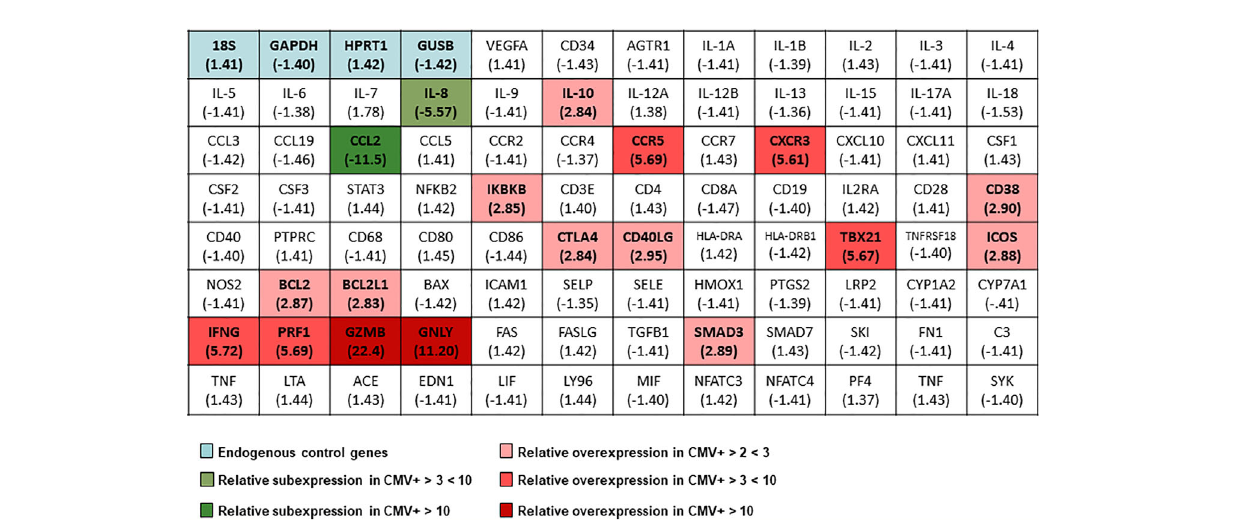
FIGURE 6 | Changes in the gene expression pro fi le in CHF patients divided according to their seropositivity to CMV measured by TaqMan ™ Array Human Immune Response. Heat map showing differential expression in patients with CHF CMV+ compared to CMV- patients. Green colors indicate under-expression in CMV+ patients and red tones overexpression in these patients. The blue color is indicating the genes used as endogenous control genes in 5 CHF CMV- and 5 CHF CMV+ patients. We used the comparative ddCT method for calculating relative quantitation of gene expression after outlier removal and data normalization based on the endogenous control genes expression using DataAssist software (Thermo Fisher Scienti fi